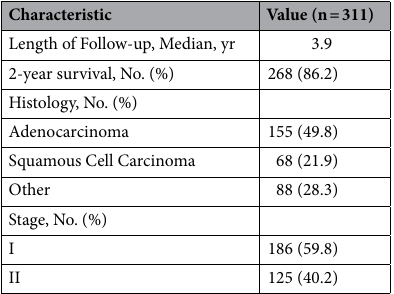
Table 1. Patient Characteristics and Follow-up Summary. a includes all other histology types, specifically, large cell and mixed histology, bronchoalveolar carcinoma, carcinoid, and cases with more than one primary tumor.